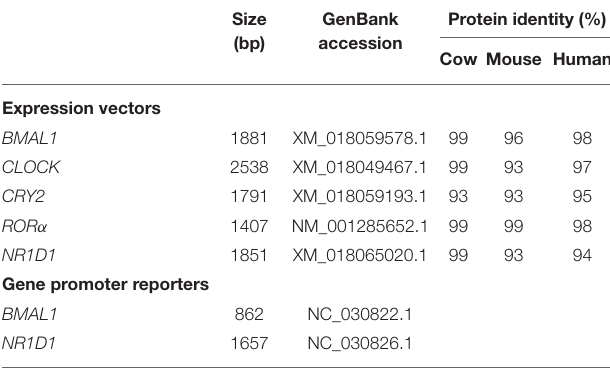
TABLE 3 | Cloning of a comprehensive set of clock genes and circadian gene promoters in the goat. Size